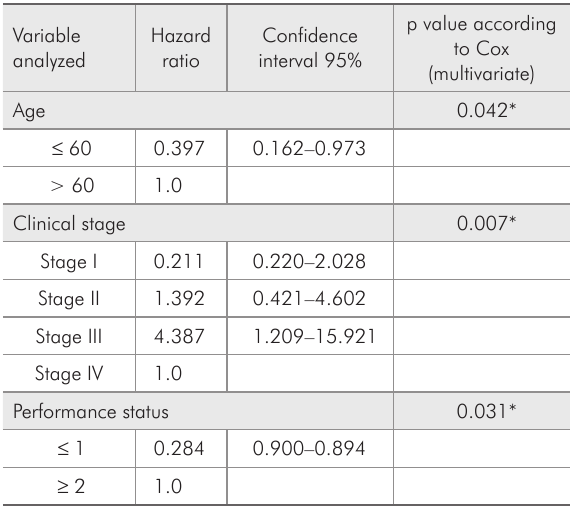
Table 2 - Potential risk factors associated with survival for subjects with DLBCL of the OC-MR, according to multivari- ate hazard ratio of Cox